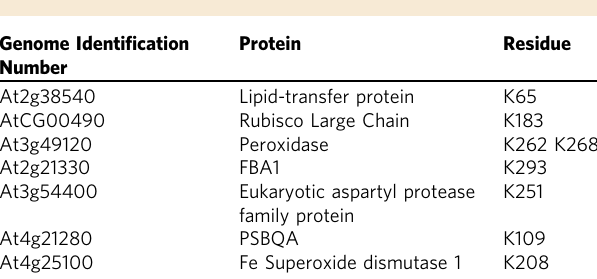
Table 1 Carbamylated proteins in A.